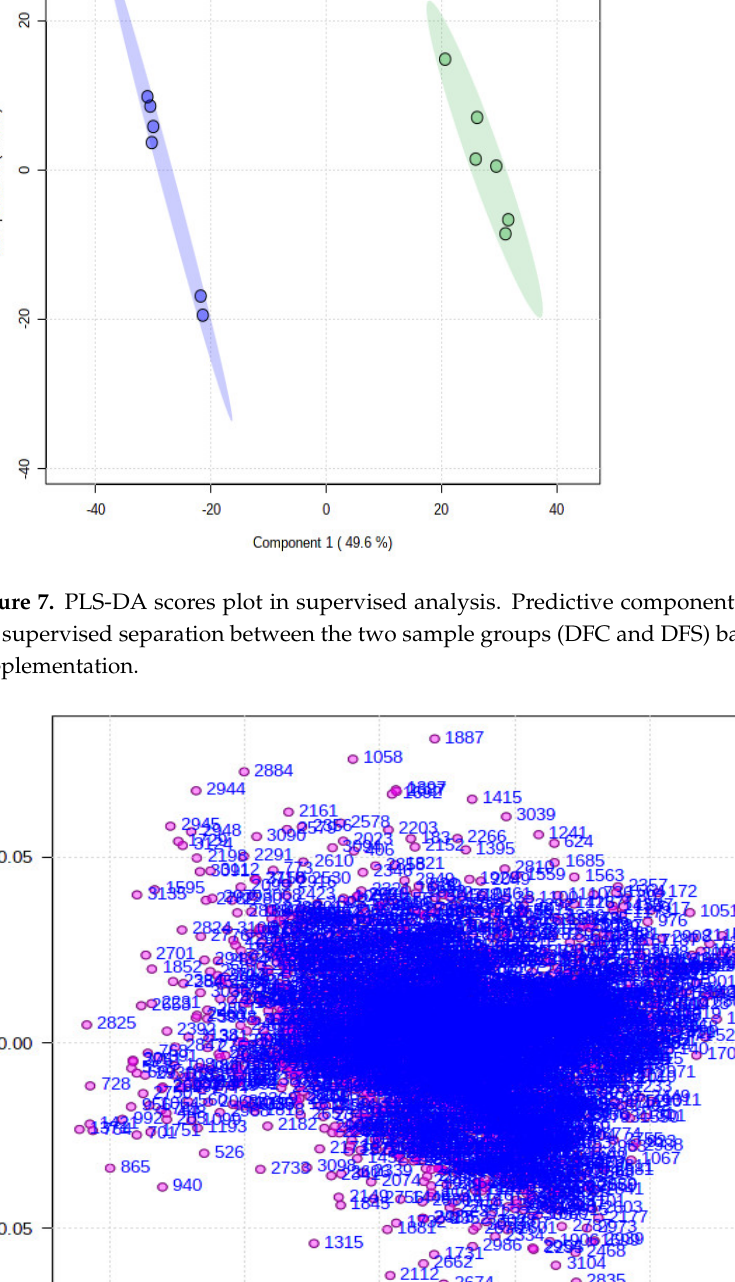
Figure 9. VIP score plot of the most important discriminant metabolites by PLS-DA for DFC and DFS. The relative abundance of each important metabolite is indicated with a colour code scaled from blue (low) to red (high). A high VIP score indicates a high impact of the metabolite as a discriminant feature among the sample groups.